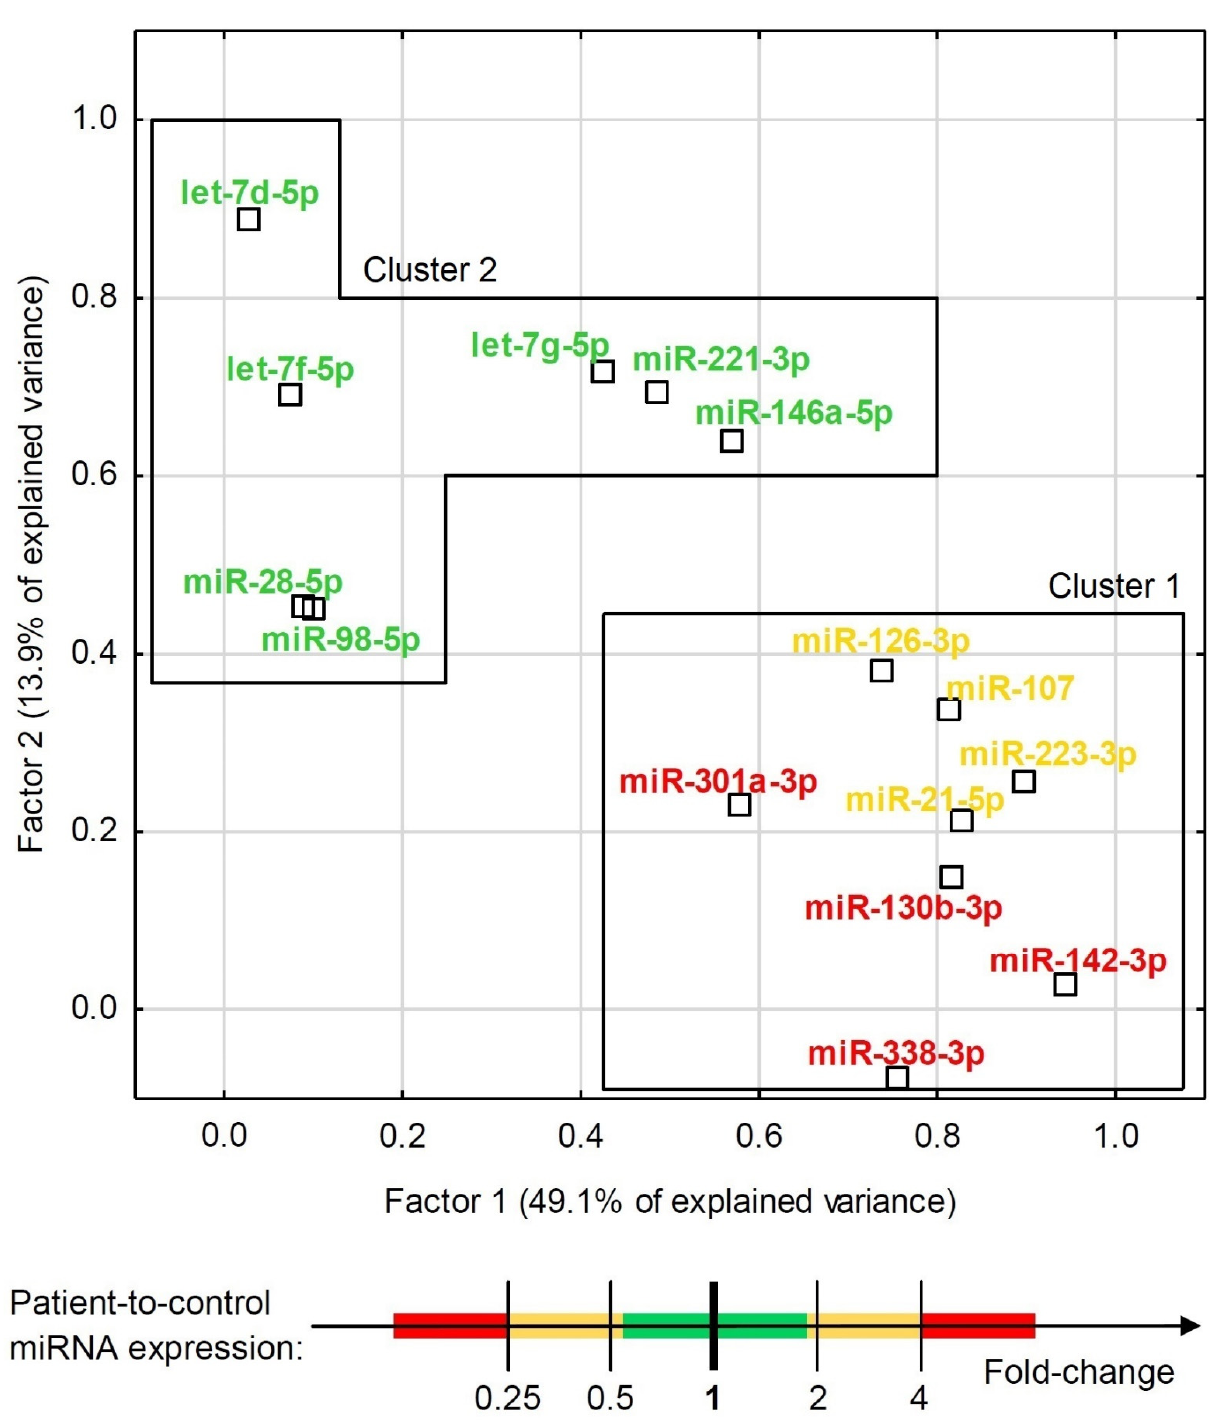
Figure 4. Exploratory factor analysis with factor loadings for expression of all the tested miRNAs in the combined group of ACS patients and healthy controls. The factor differentiation was achieved via raw varimax factor rotation. Two factors accounted for 63.0% of the total variance. MiRNAs are indicated with colors that represent their relative ACS patient-to-control expression.